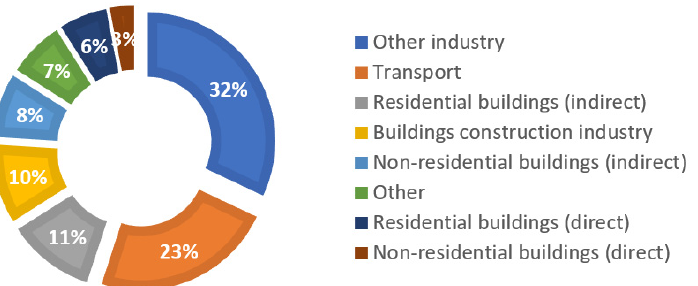
Figure 2. Global share of buildings and construction final CO 2 emissions 2019. Adapted from [10].